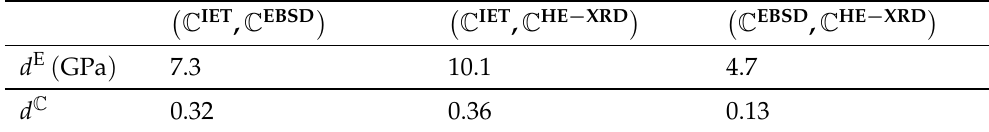
Table 3. Distance measures between elasticity tensors determined by the different approaches.